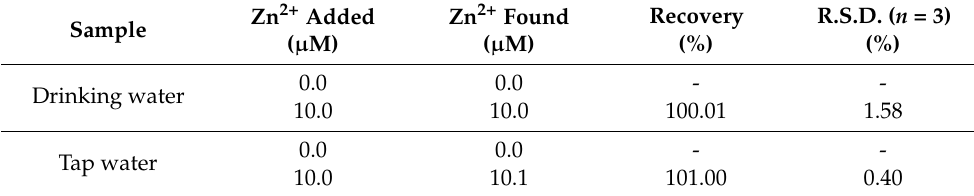
Table 1. Determination of Zn 2+ .